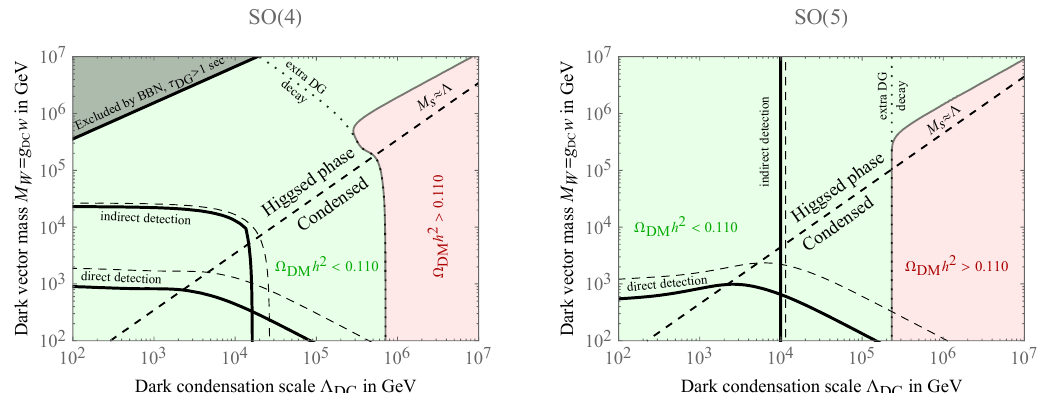
Figure 3 . As in (cid:12)gure 1, for SO( N ) models. The left plot shows an example with N even (DM is the baryon with one W constituent). The right plot shows an example with N odd (DM is the baryon with zero W constituents). In the right panel, the non-perturbative DM annihilation cross-section cannot be matched to its perturbative value: we assume (cid:27) ann (cid:25) 100 = (cid:3) 2 Specializing eq. (2.9) to the unbroken H = SO( n ) group, so that (cid:20) = 1, d N (cid:0) 1, C = n (cid:0) 1 and C = 2( n (cid:0) 2) in our normalization, we obtain the annihilation fund adj cross sections relevant for the usual decoupling of free W